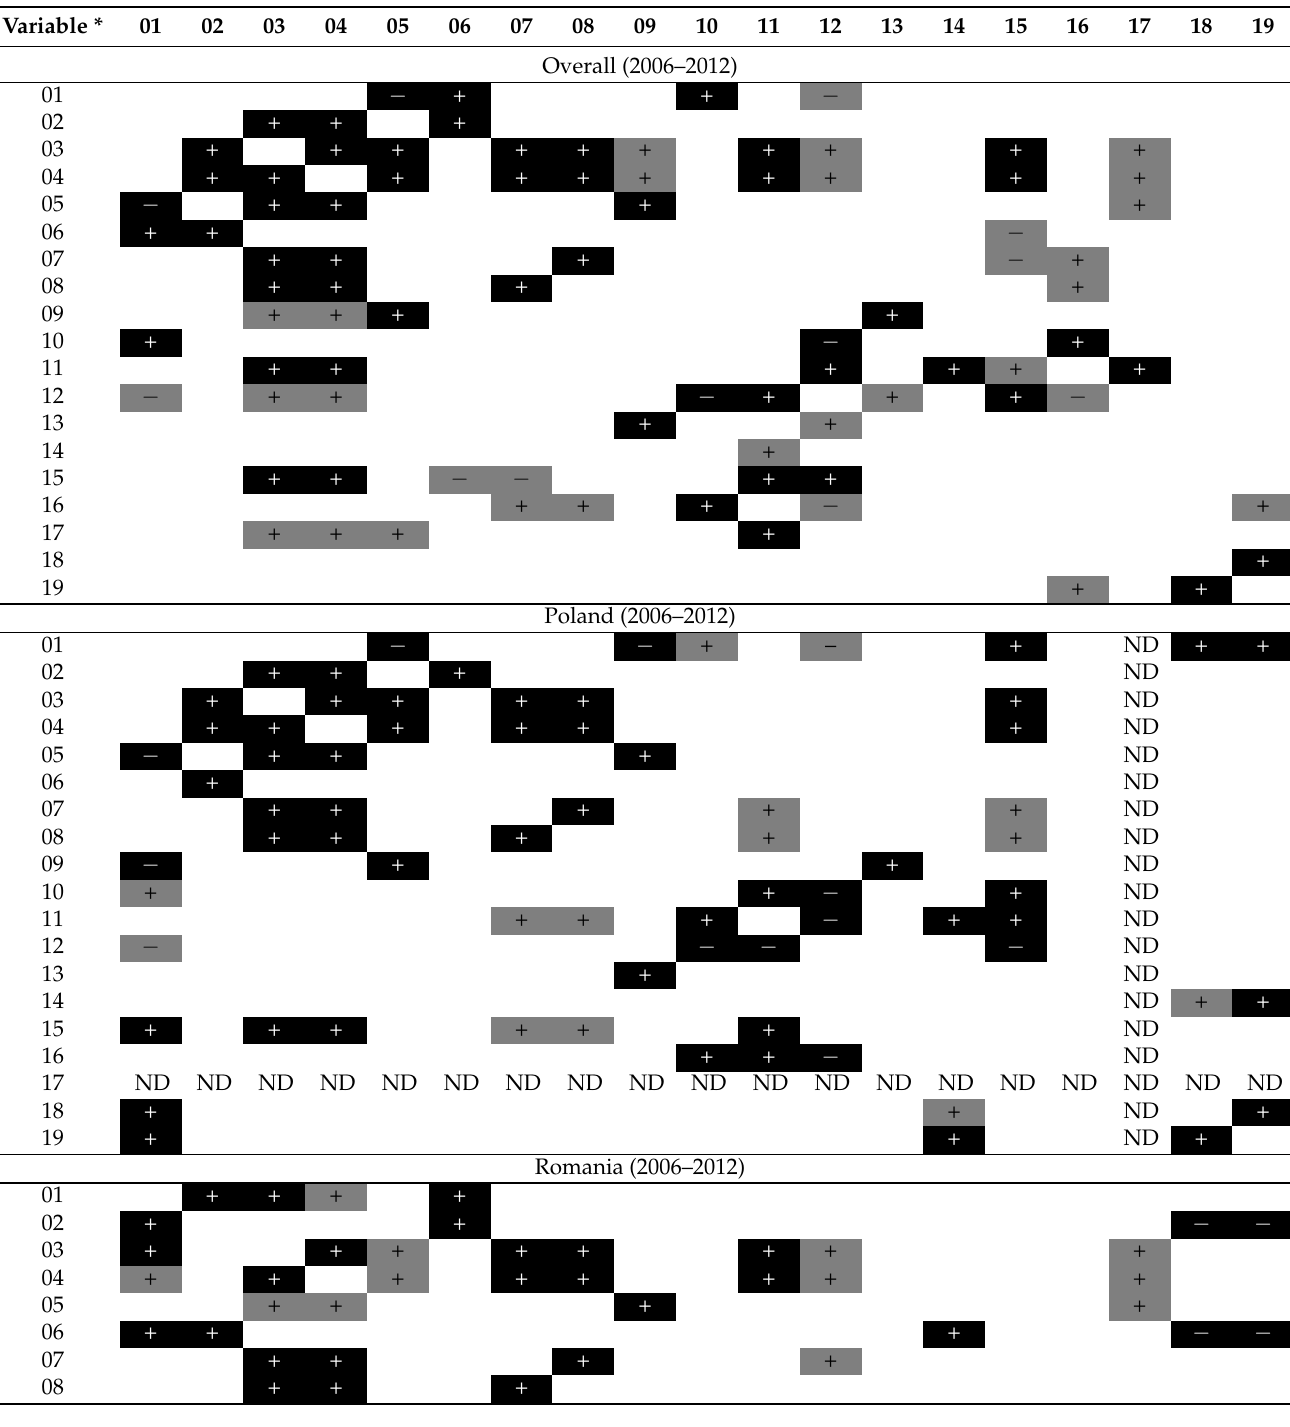
For this reason, the results of the correlation analysis, displayed in Table 5, are more relevant. The table displays the results for both countries taken together, as well as for Poland and for Romania separately. One might find a correlation between the raw gain and loss of OGA surprising; however, this is a typical case of confounding, where both indicators are related to the city size; more precisely, the larger the city, the larger the areas affected by the gain or loss of OGA. This is why the correlation is no longer present when the gain and loss are computed as a share of the urban area. Table 5. Correlation analysis of the variables describing the changes of OGA and possible